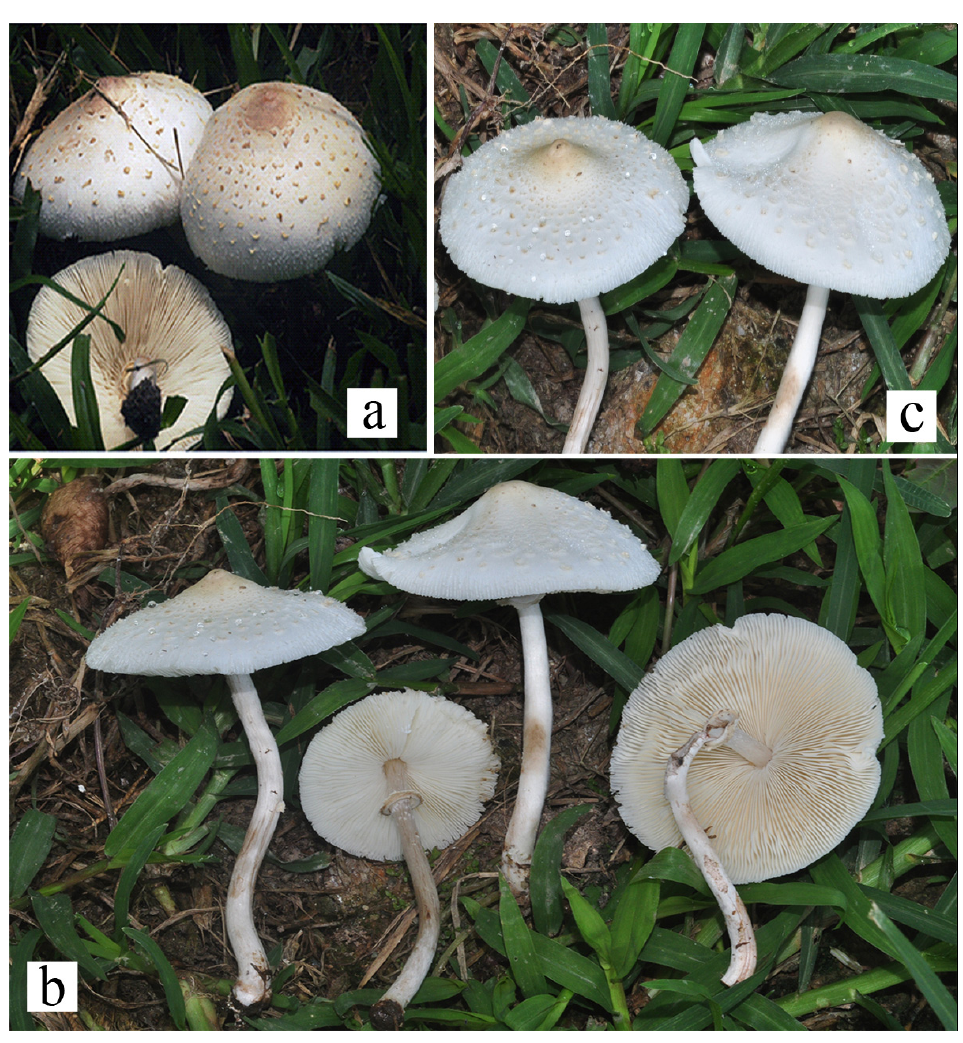
Figure 9. Fresh basidiomata of Chlorophyllum hortense . ( a ) MFLU 12-1783. ( b , c ) MFLU 19-2352.